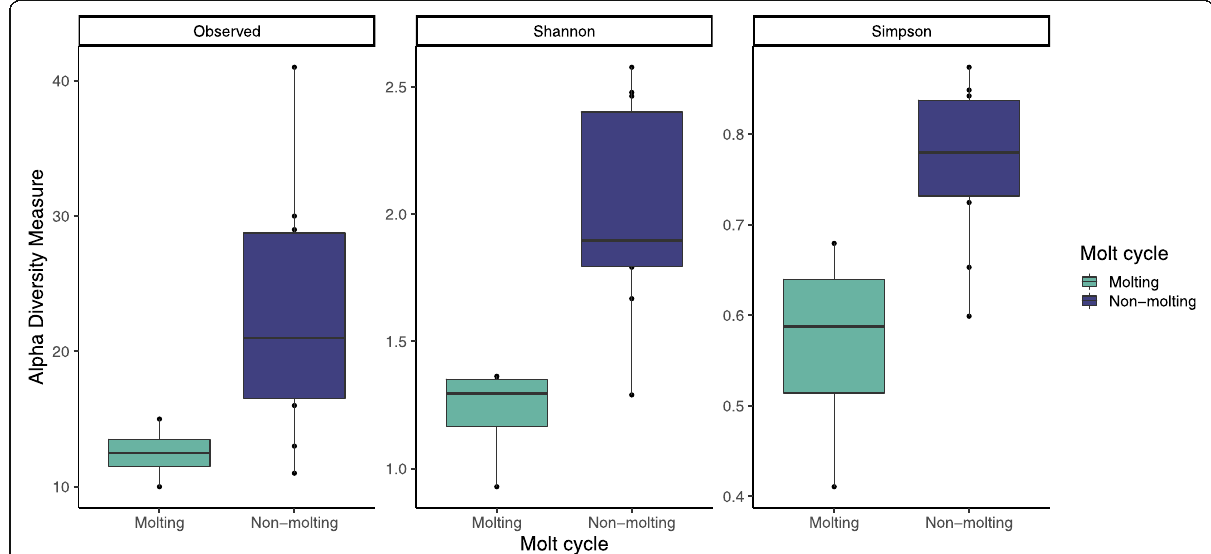
Fig. 5 Observed richness (number of ASVs), Shannon, and Simpson indices of alpha diversity among epidermal microbial communities in actively molting and non-molting animals live-captured in Bristol